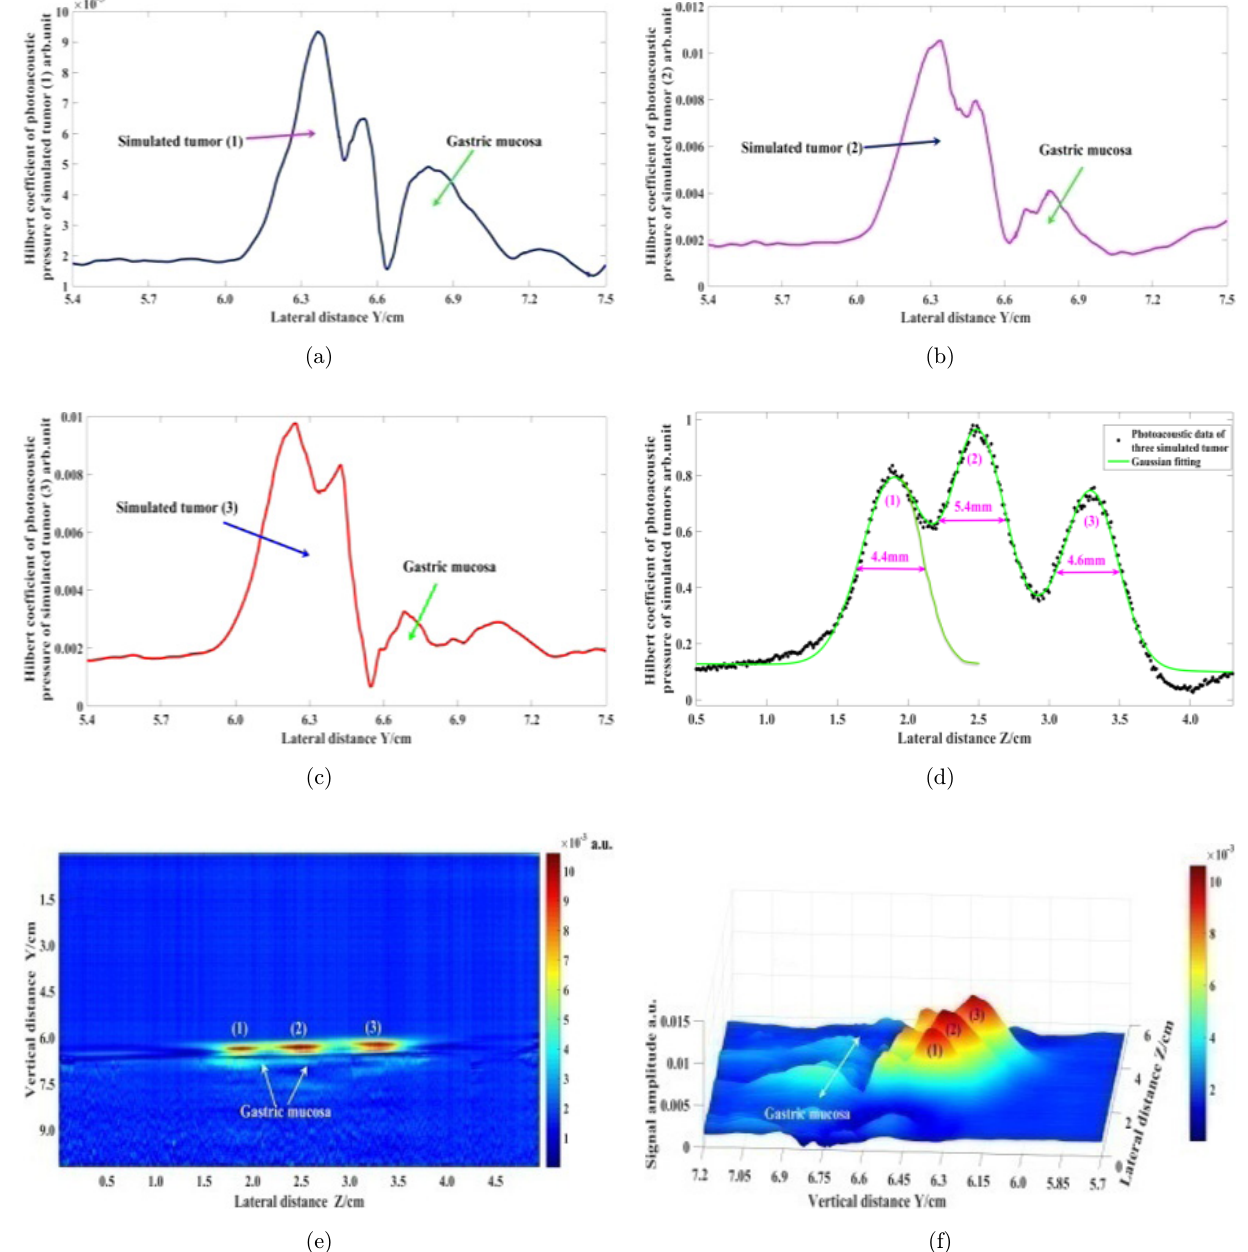
Fig. 6. PAI of simulated tumor (1) – (3) in transversal detection. (a) Hilbert transform results of photoacoustic signals of simulated tumor (1); (b) Hilbert transform results of photoacoustic signals of simulated tumor (2); (c) Hilbert transform results of photo- acoustic signals of simulated tumor (3); (d) Photoacoustic signal corresponding to the position in Y position at 6.3 cm, Gaussian was used as a ¯tting function to ¯t the raw data, ¯tting curve shows as green line; (e) Two-dimensional PAI of gastric tumor detection in animal phantom in transversal detection; (f) Three-dimensional photoacoustic signal amplitude imaging of three simulated gastric tumors detection in animal phantom in transversal